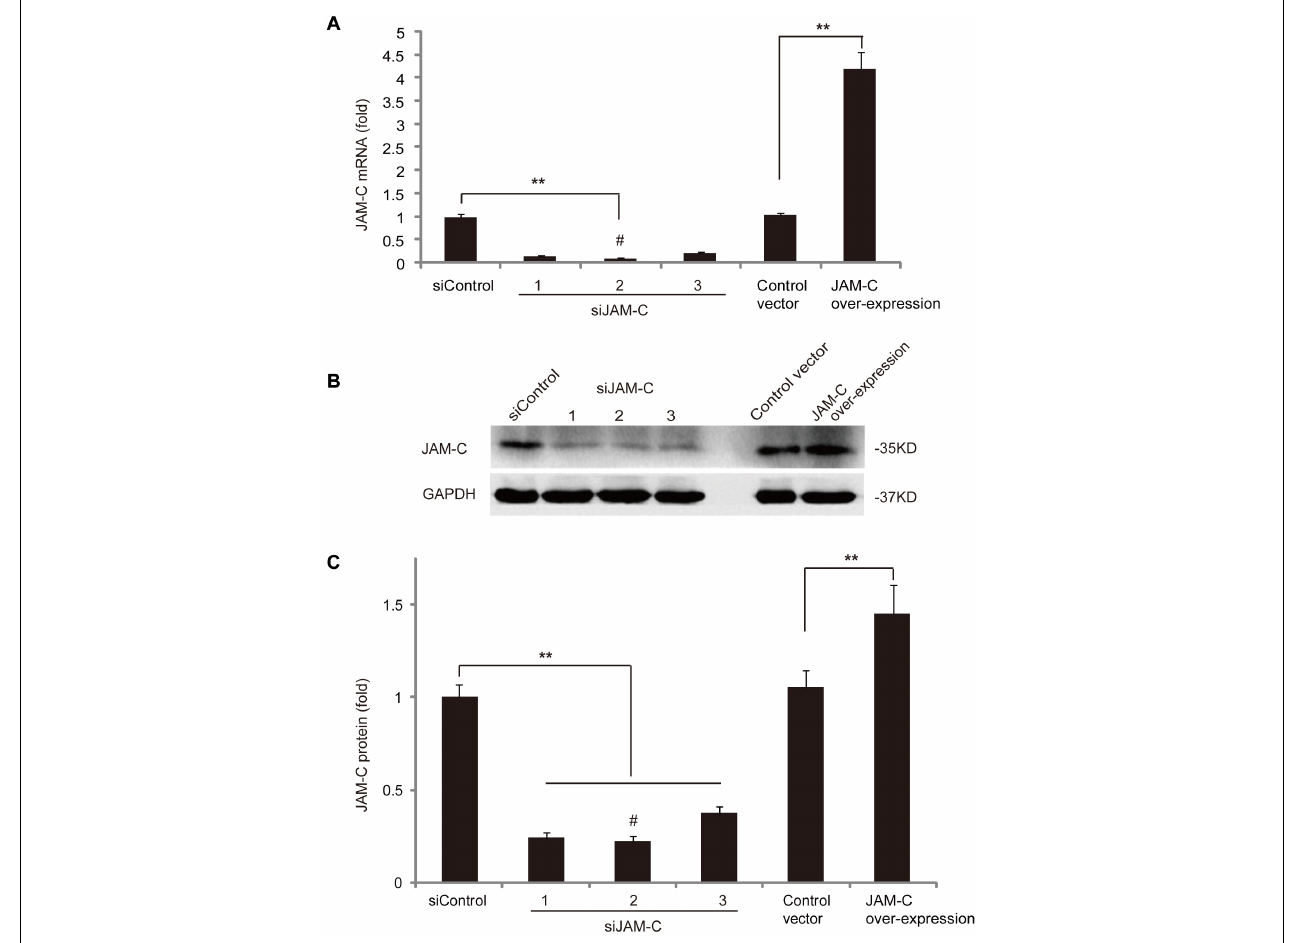
FIGURE 2 | JAM-C overexpression and knockdown in human RCECs. (A) Three different siRNAs for JAM-C knockdown were cloned into lentiviral vectors and transfected into RCECs. Knockdown efficiency was verified by RT-qPCR. The second siRNA construct most effectively reduced JAM-C mRNA expression to about 12%. For gain-of-function analysis, human JAM-C was cloned into a lentiviral vector and transfected into RCECs. RT-qPCR showed an approximately 4.3-fold increase of JAM-C transcripts. (B,C) For loss-of-function analysis, Western blot showed that the second siRNA construct was the most efficient and reduced JAM-C protein level to about 25%. For gain-of-function analysis, Western blot showed an approximately 1.5-fold increase of JAM-C protein in RCECs overexpressing human JAM-C . ** P < 0.01. # : Used for subsequent experiments.